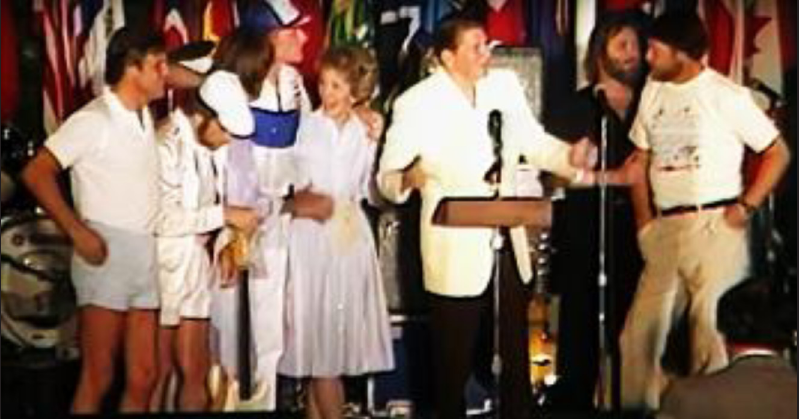
Figure 3: The President and the Beach Boys, June 12, 1983 (Reagan Library,